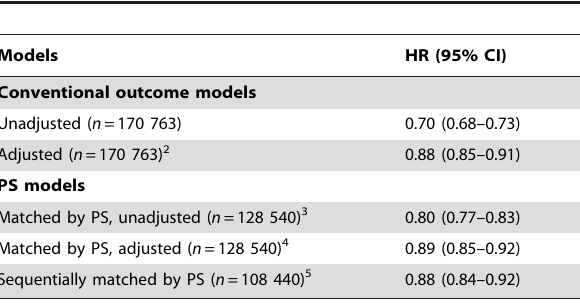
Table 3. Comparative effectiveness of atorvastatin (10 mg) versus simvastatin (20 mg) estimated